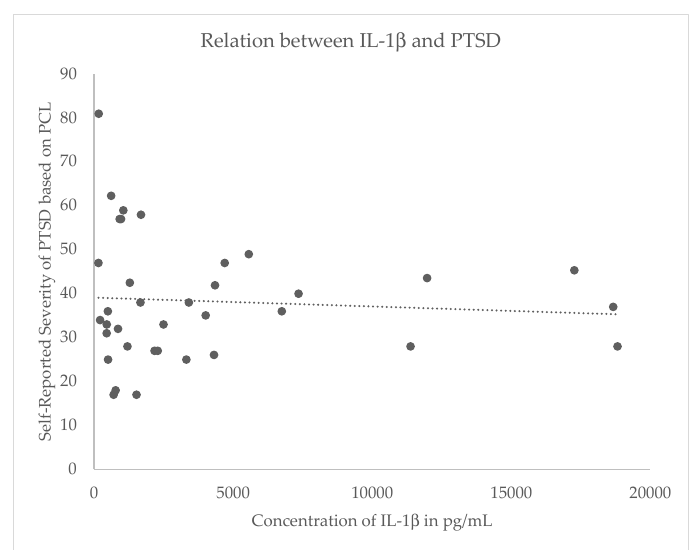
Figure 1. Steiger’s Z* revealed differential relations between IL-1 β and depressive symptoms (top), IL-1 β and anxiety symptoms (middle), and IL-1 β and post-traumatic stress symptoms (bottom). While these relations were not significant, the difference in correlation coefficients was significant, indicating that there is a differential relation between inflammation and trauma-related psychopathology. Y axes reflect self-reported symptom severity scores for the Hopkins Symptoms Checklist (HSCL)-depression index (range: 0–4) (top), HSCL-anxiety index (range: 0–4) (middle), and posttraumatic stress disorder (PTSD) Checklist for Civilians (PCL) for DSM IV (range: 17–85) (bottom).